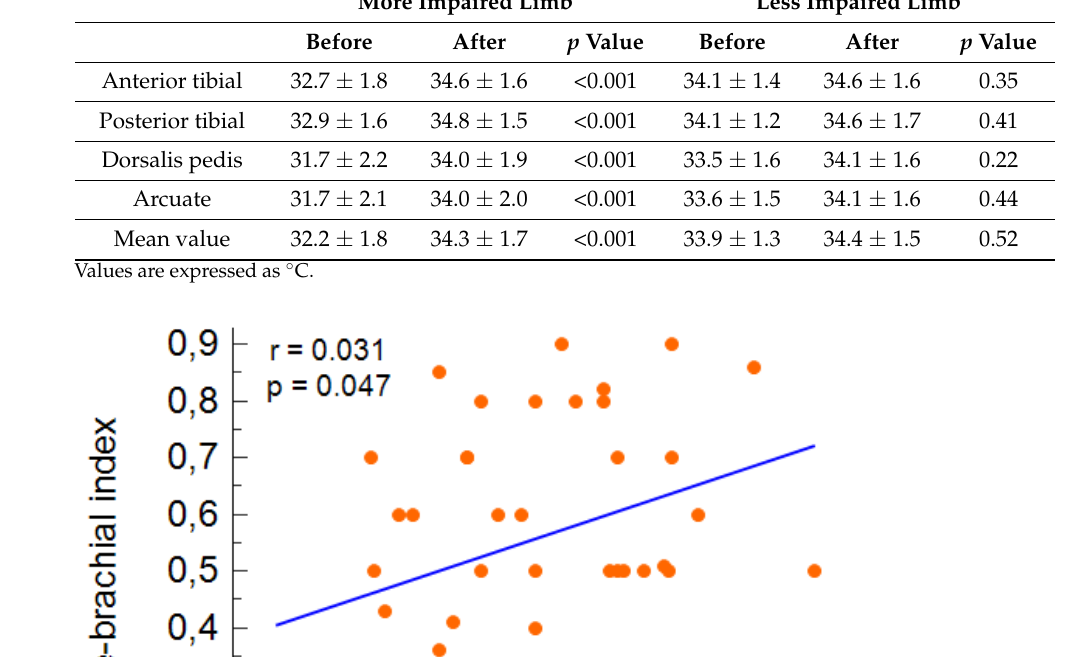
Table 4. Global and specific district temperature changes before and after limb revascularisation.